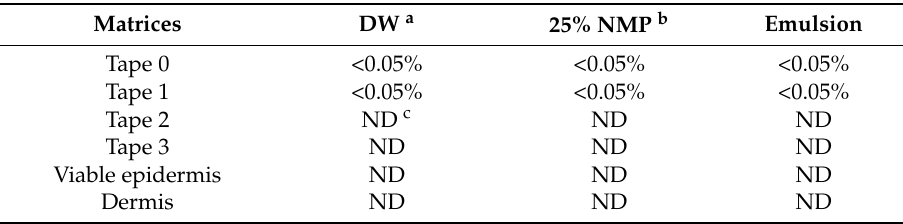
Table 2. Concentrations of melittin in various matrices of